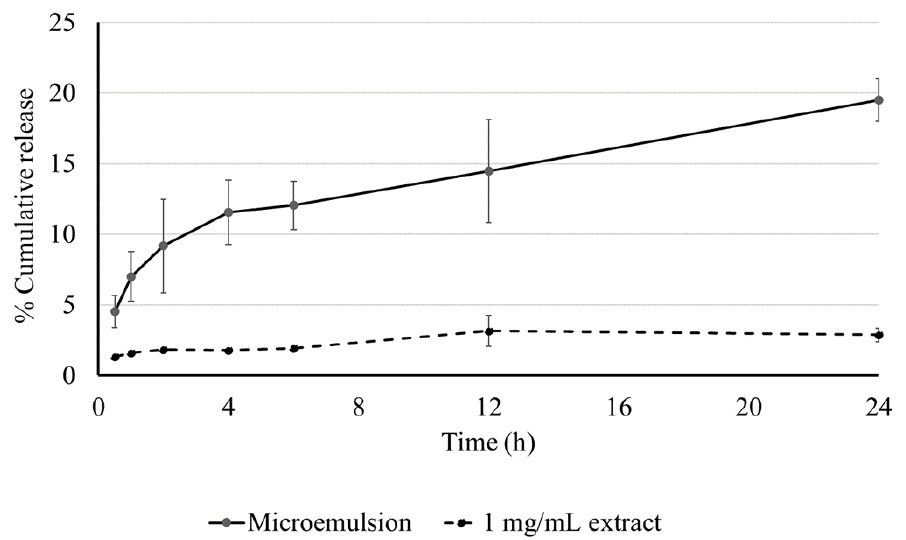
Figure 3. The release profile of the microemulsion and extract at various time intervals. The data are represented as % cumulative release.